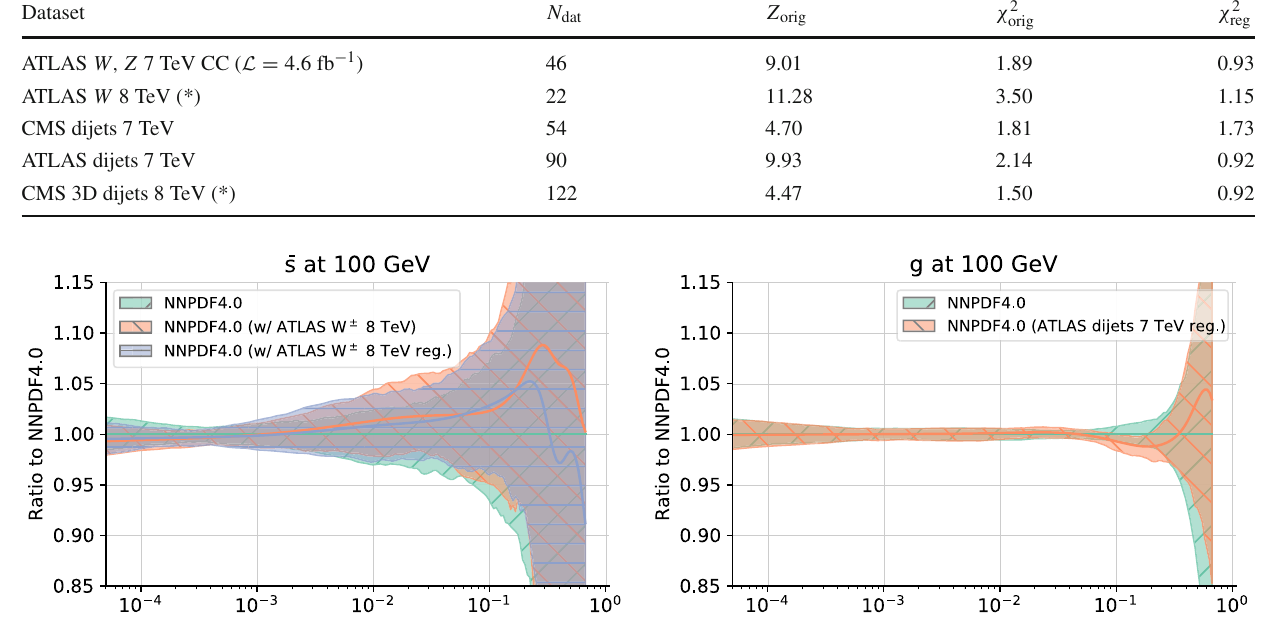
Table 32 The values of the χ 2 in NNPDF4.0 variants in which the covariance matrices for selected datasets have been regularized follow- ing the procedure discussed in the text. For each dataset, we indicate the number of data points, the original values of the fit quality χ 2